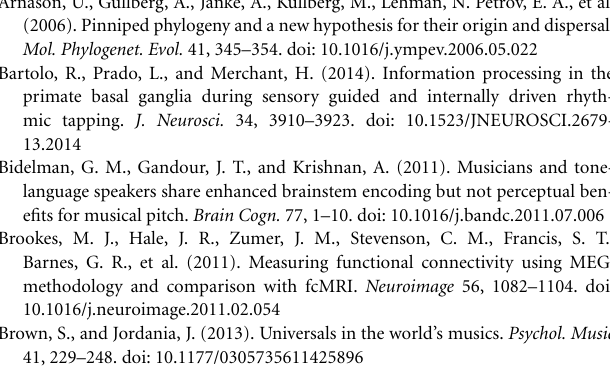
metronome. Figure 6 (left) shows a circular histogram of relative phase values between taps and tones for a human adult tapping to an auditory metronome with a period of a 600 ms (from Iversen et al., in press). The relative phase values cluster tightly around 0 degrees (which corresponds to perfect alignment between taps and tones). Figure 6 (right), from Hattori et al. (2013), shows the relative phase values of Ai’s tapping to a metronome with a period of 600